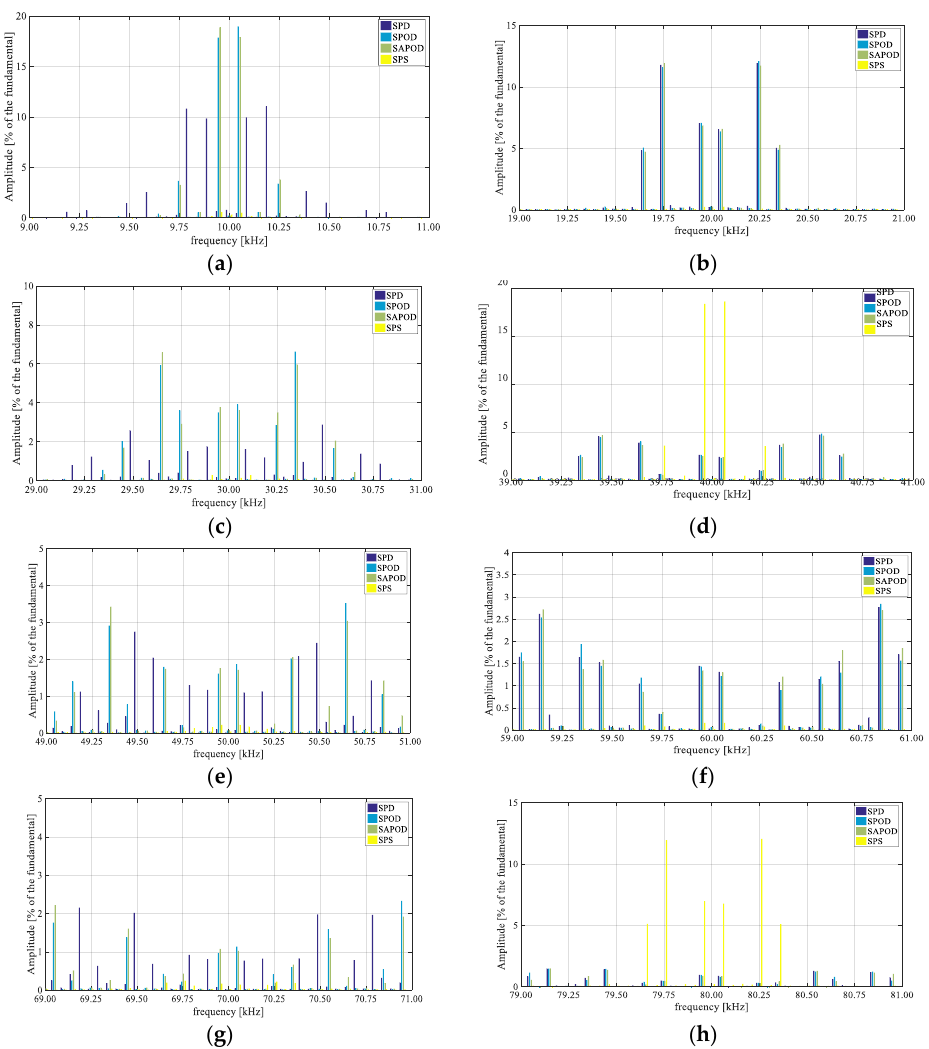
Figure 13. Comparison between the harmonic spectra around the center of multiples of the switching frequency for m equal to 0.5: SPD (blue bar), SPOD (light-blue bar), SAPOD (green bar) and SPS (yellow bar). ( a ) harmonic spectrum centered at 10 kHz; ( b ) harmonic spectrum centered at 20 kHz; ( c ) harmonic spectrum centered at 30 kHz; ( d ) harmonic spectrum centered at 40 kHz; ( e ) harmonic spectrum centered at 50 kHz; ( f ) harmonic spectrum centered at 60 kHz; ( g ) harmonic spectrum centered at 70 kHz; ( h ) harmonic spectrum centered at 80 kHz.